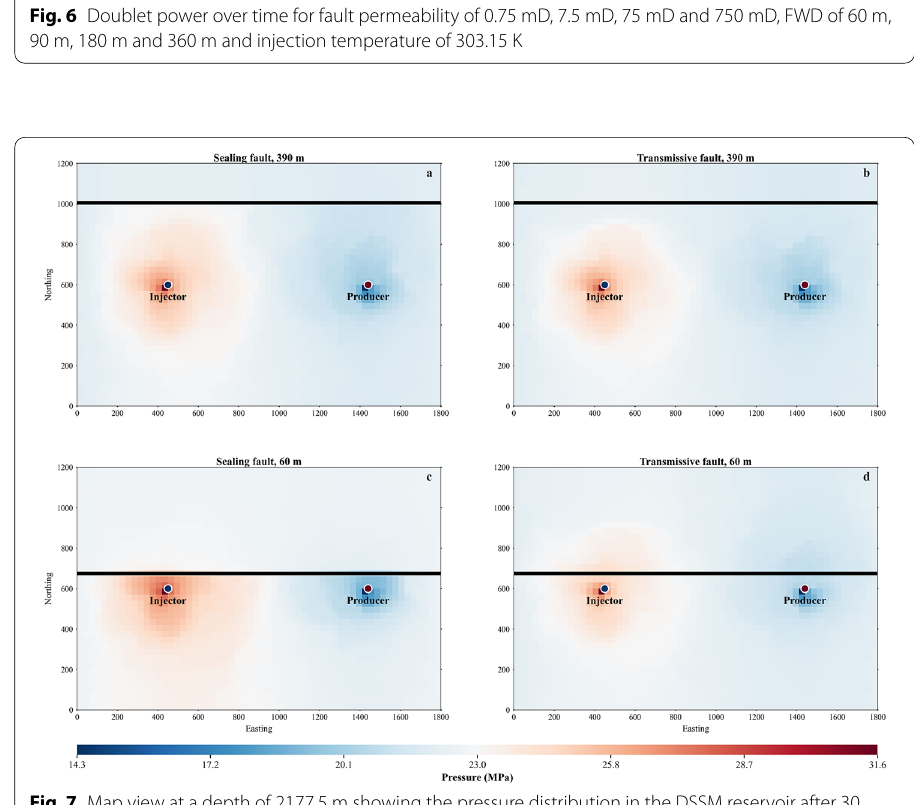
Fig. 7 Map view at a depth of 2177.5 m showing the pressure distribution in the DSSM reservoir after 30 years of production with an FWD of 390 m ( a , b ) and 60 m ( c , d ) for a sealing ( a , c ) and a transmissive fault ( b , d ). Data shown use an injection temperature of 303.15 K and a flowrate of 9000 m 3 / day . Injector and producer wells are marked with a blue and red point respectively and the fault position is indicated in